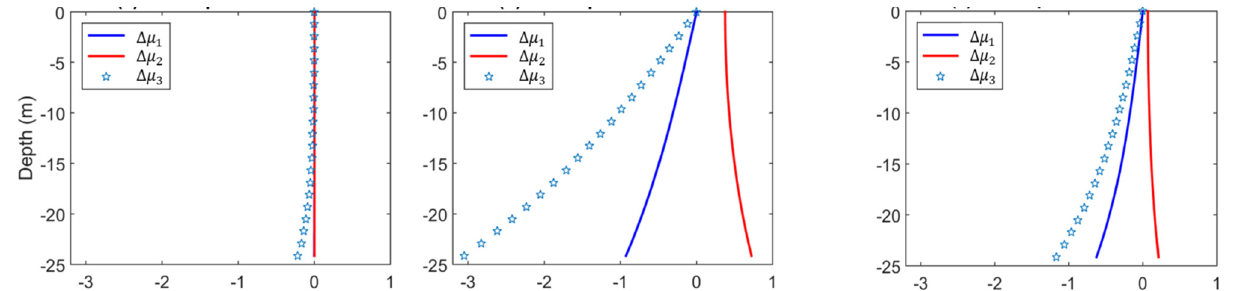
Figure 4. Change in coastal ocean waves at different times during the storm surge process at the same location.